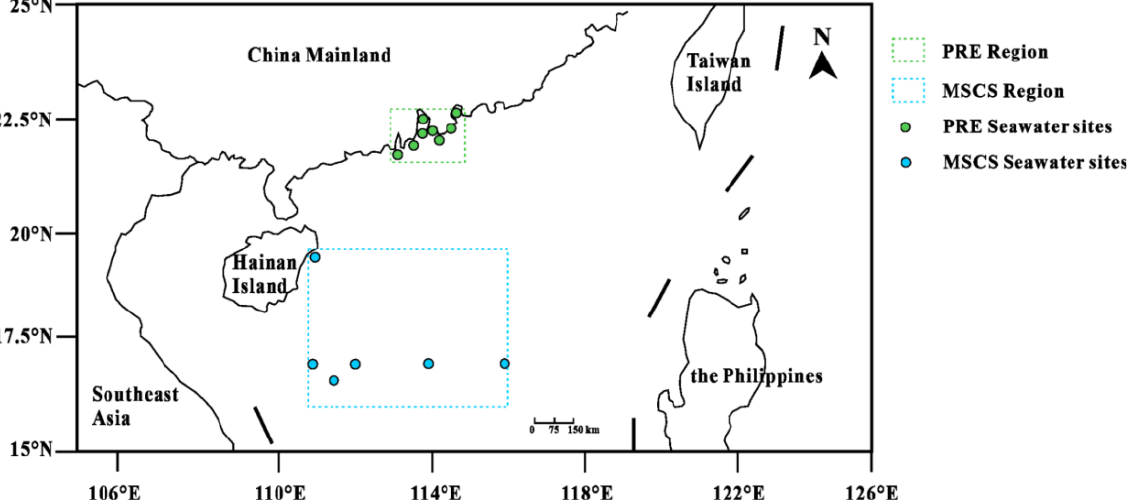
Figure 1. Nearshore (Pearl River Estuarine (PRE)) and offshore regions (the middle of the South China Sea, MSCS)in the South China Sea of this study. The dashed lines of green and blue represent the range of study areas. All of the fish samples were collected in the dashed line range. The green and blue spots represent the seawater sampling sites of the PRE and MSCS regions, respectively.